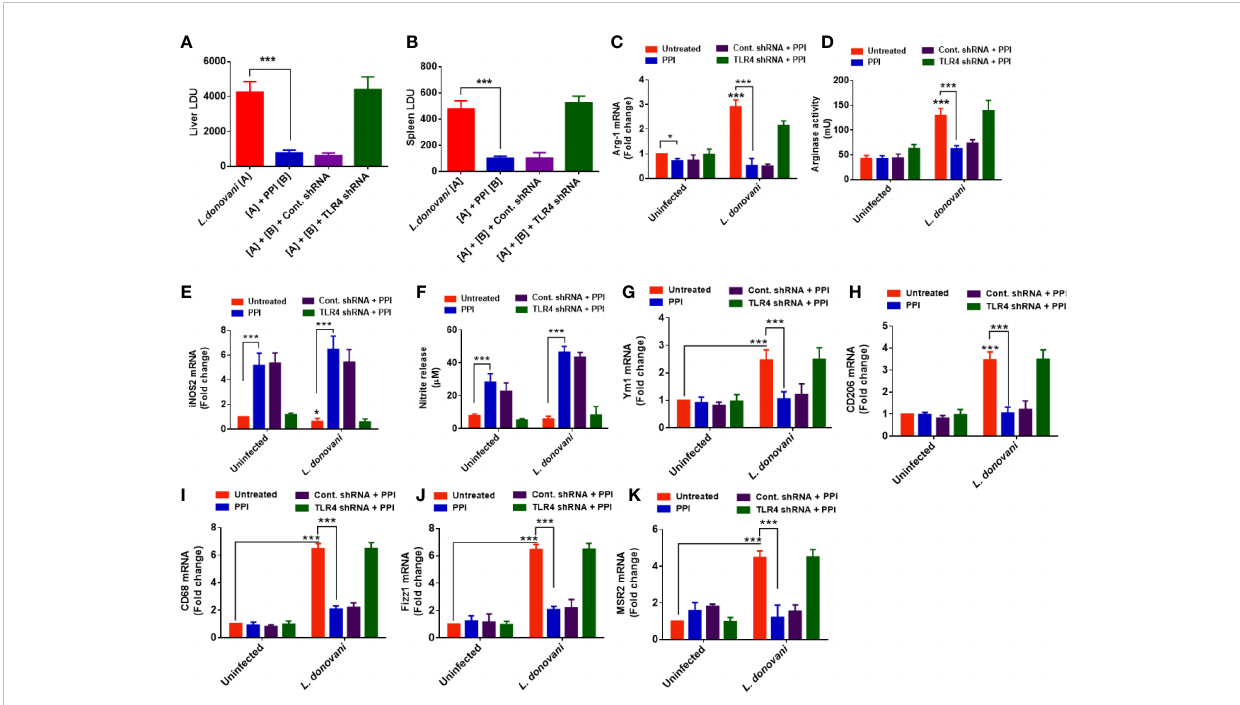
FIGURE 5 The protein protease inhibitor (PPI) decreased the parasite load in the liver and spleen via TLR-4. BALB/c mice (6 – 8 weeks old) were transfected with TLR4 shRNA, infected with L. donovani promastigotes, and treated with the PPI (1 mg/kg B.W.) for a total of four doses in two alternating days. On the 15th day of the last dose of treatment, the mice were sacri fi ced. Stamp smears were made from liver and spleen tissues and stained with Giemsa, and the parasite load expressed in Leishman Donovan units was enumerated. (A – B) The results were expressed as mean ± SD of n = 6 for each group. The asterisks indicate a signi fi cant difference between the infected control and the PPI-treated group. * p ≤ 0.05, ** p ≤ 0.01, and *** p ≤ 0.001. The splenocytes were isolated from each group and re-stimulated with 10 µg/ml of soluble Leishmanial antigen (SLA). (C, E) After 48 h of SLA stimulation, the nitrite levels were estimated from cell-free supernatant, and arginase activity was studied from the cell lysates. After 6 h of SLA stimulation, cells were collected in Trizol and the total RNA was isolated. Then, the mRNA expression was studied using real-time PCR with arginase-1 (C) , iNOS2 (E) , YM-1 (G) , CD206 (H) , CD68 (I) , FIZZ1 (J) , and MSR2 (K) speci fi c primers. All the results were expressed as mean ± SD. * p < 0.05, and *** p <